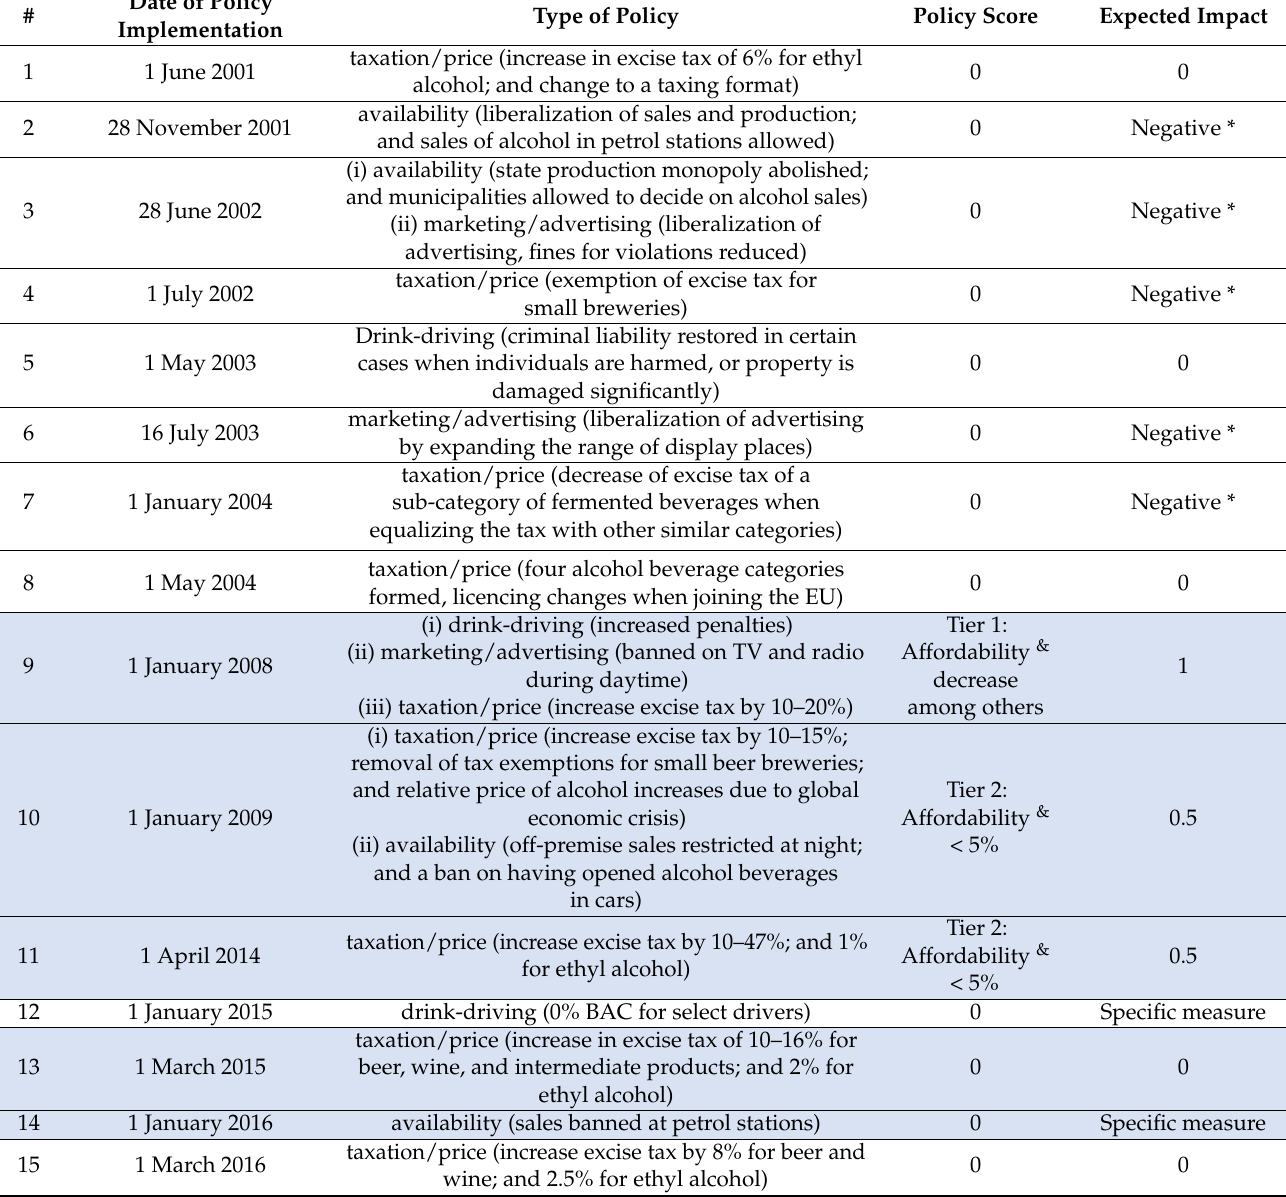
Table 2. Major alcohol control policies implemented between 2001 and 2019 in Lithuania (for further details, see